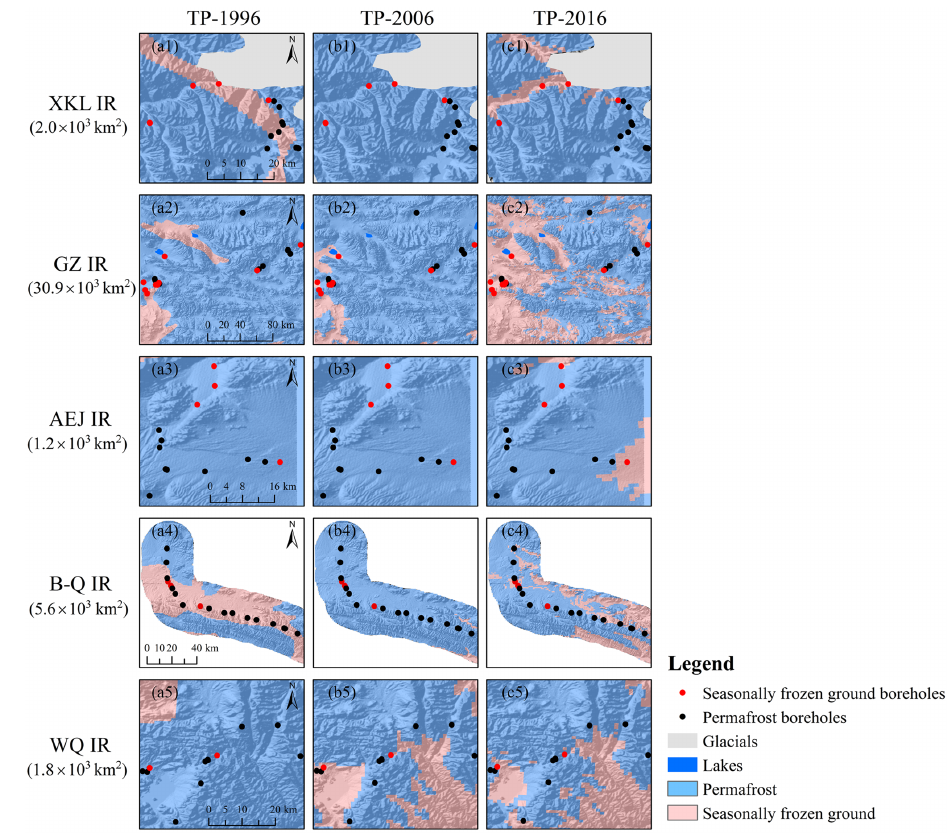
Figure 4. Spatial distribution of boreholes in five IRs of three maps.